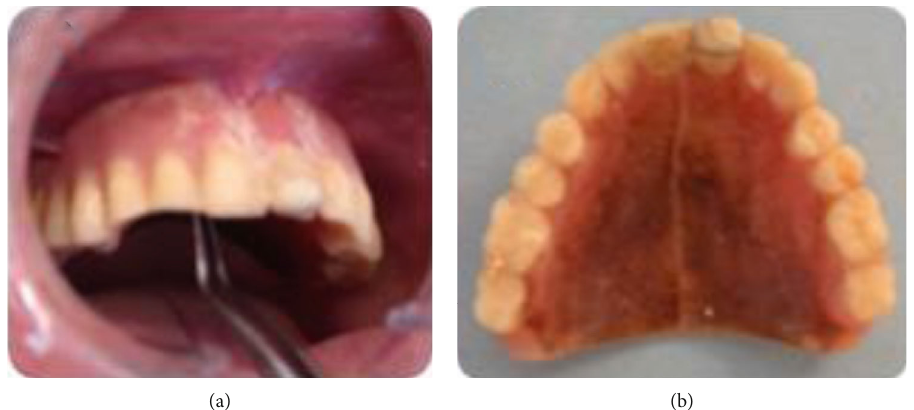
Figure 23: (a, b) Prosthesis examination: an ill- fi tting prostheses.